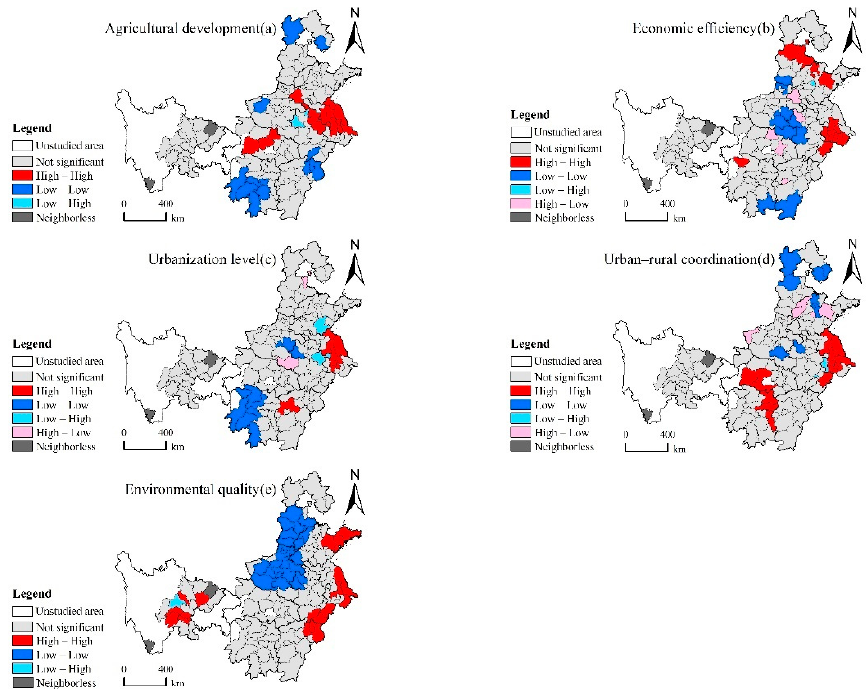
Figure 4. LISA cluster maps for the subdimensional quality of MGPAs in 2018.